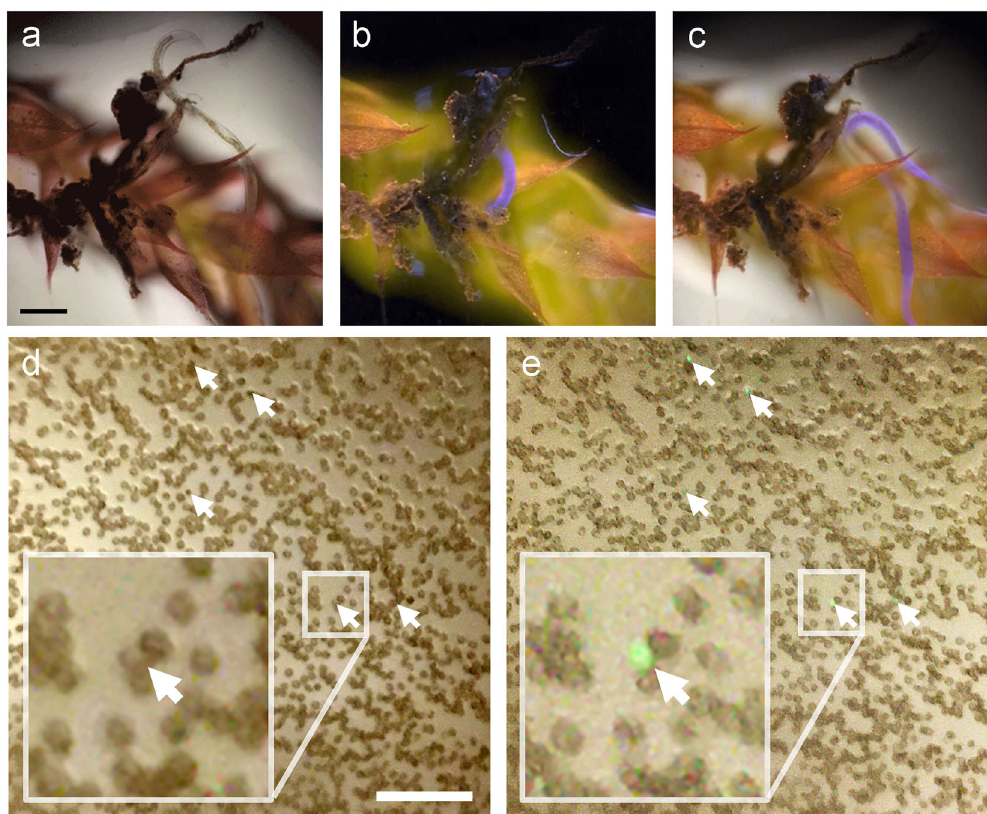
Fig. 7 Examples of bright- fi eld and hybrid mode imaging. a – c A live roundworm (the purple-blue structure in ( b ) and ( c )) moves around a piece of grimmia moss (Supplementary Video. 3). The sample was stained in 0.05% w/v rhodamine B and 0.01% w/v DAPI, washed in tap water, and imaged with ( a ) bright- fi eld mode, ( b ) MUSE fl uorescent mode, and ( c ) hybrid mode (simultaneous bright- fi eld and fl uorescence). d , e A 5% v/v blood sample stained with ~0.01% w/v acridine orange. The sample was smeared on the sample holder surface, and the same region was imaged with ( d ) bright- fi eld mode and ( e ) hybrid mode. Most disk-shaped RBCs are distinguishable under the bright- fi eld contrast. White arrows point to the cell nuclei of potential WBCs stained with acridine orange which does not show up in the bright- fi eld image. A region of each image, labeled with the smaller box (box size ~70 × 70 µ m 2 ), is zoomed four times and shown in the bigger box. Identifying RBCs and structures with nuclei in a blood smear has diagnostic potential. Scale bars: 100 µ